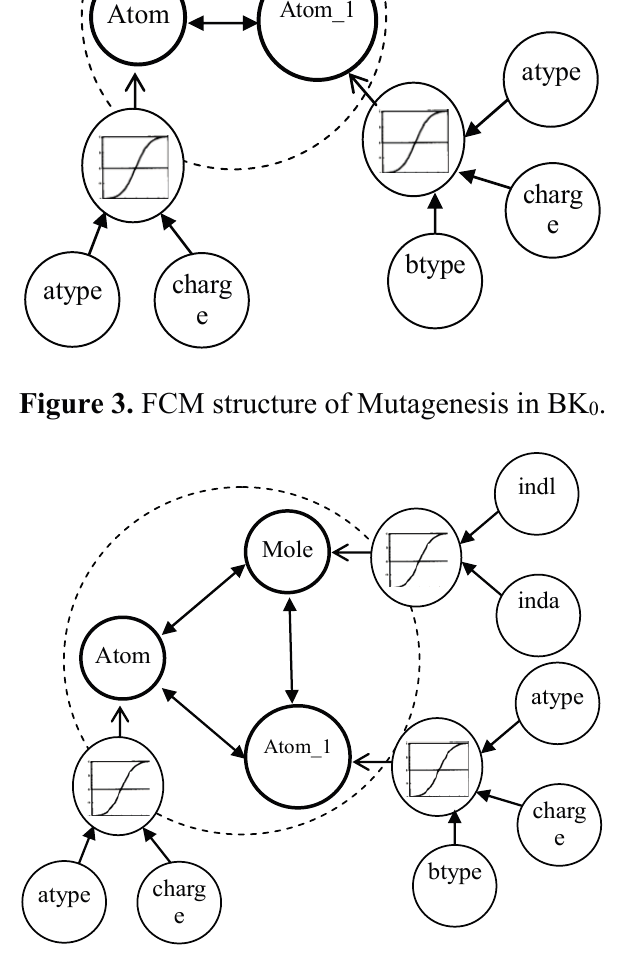
Figure 4. FCM structure of Mutagenesis in BK 1